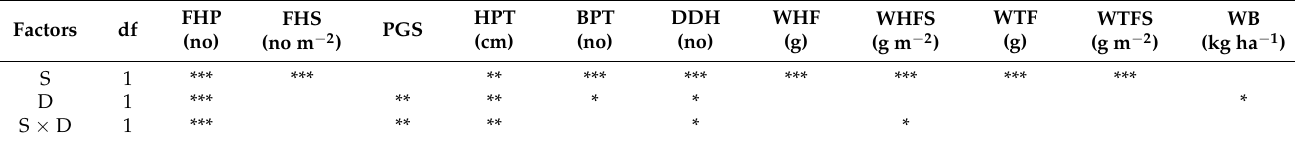
Table 4. Analysis of variance (ANOVA) applied to the mixed model.